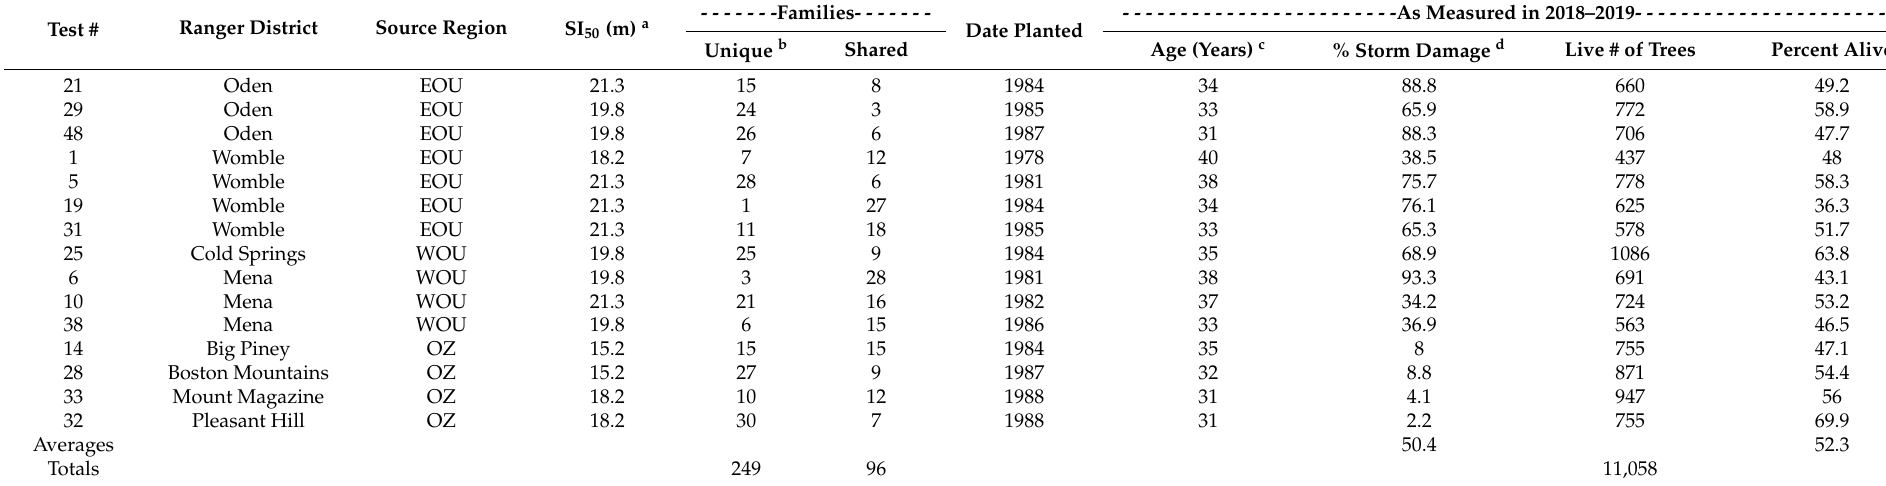
Table 1. Information on test sites, families, and trees by test site in the shortleaf pine progeny plantations on the East Ouachita (EOU), West Ouachita (WOU), and Ozark (OZ) seed source regions.